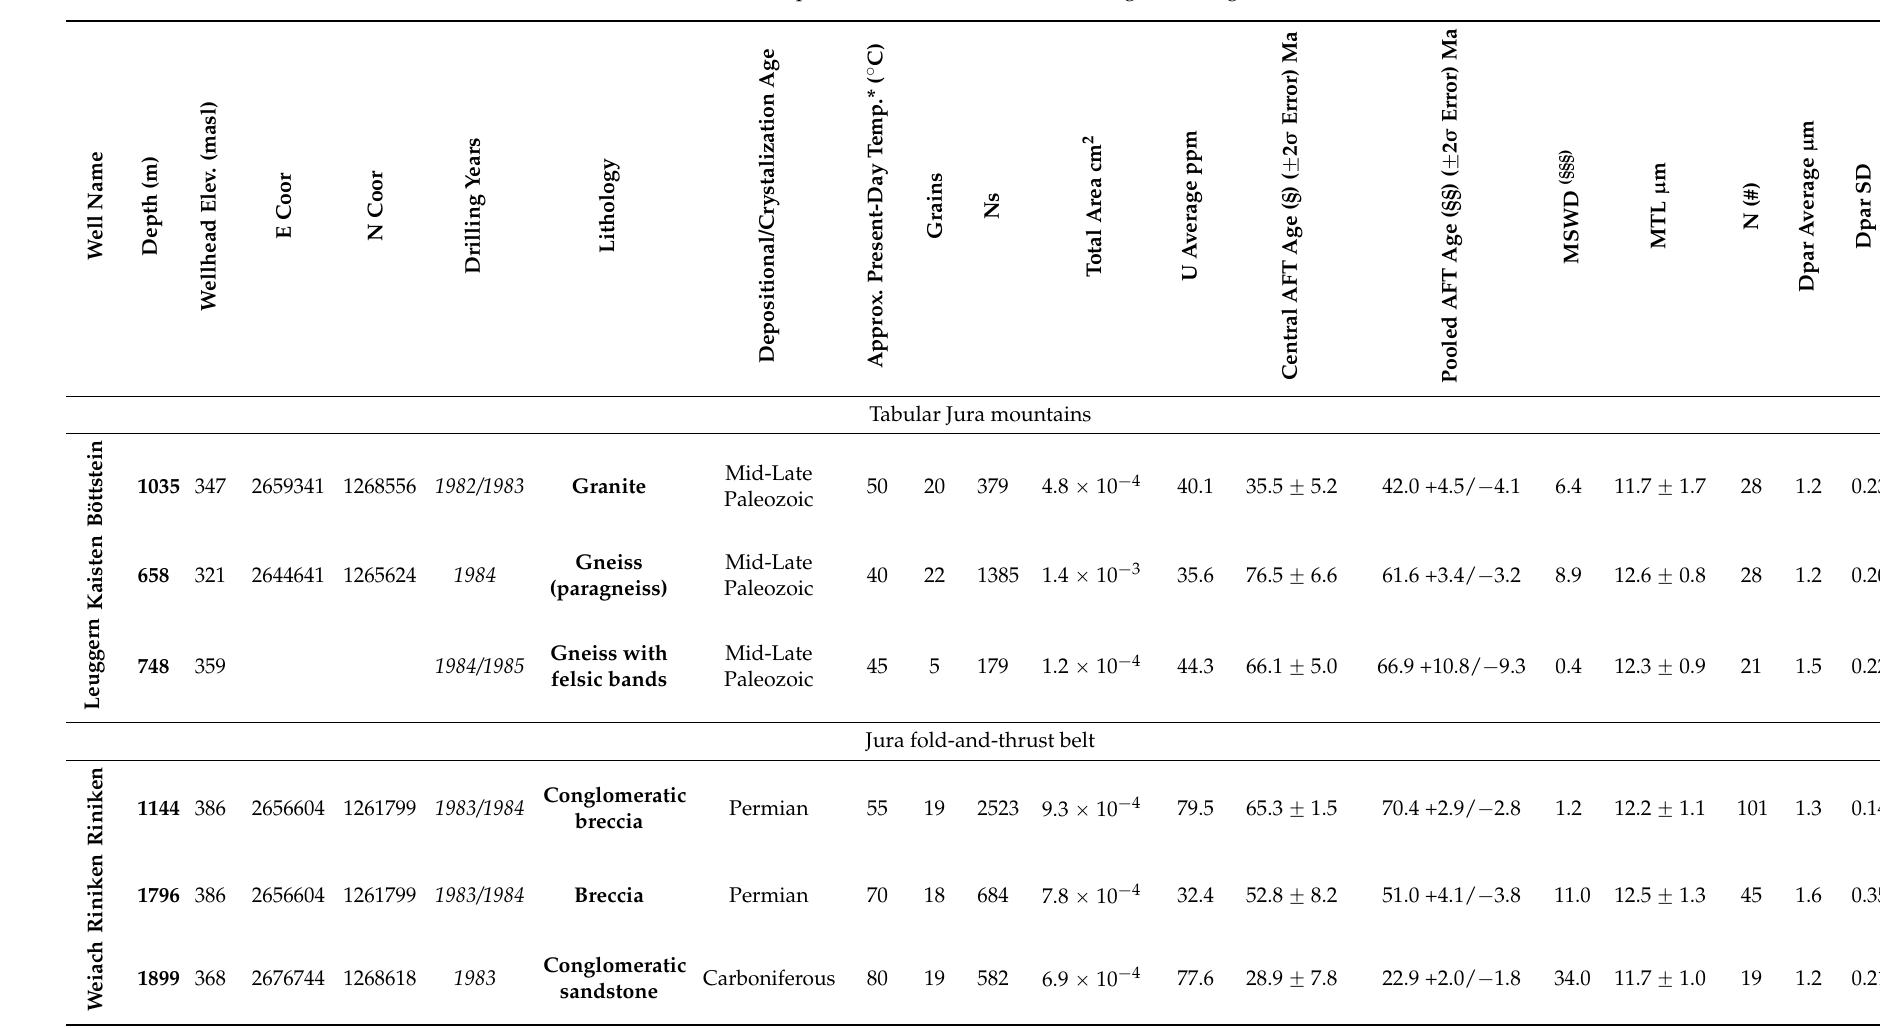
Table 1. New apatite fission track LA–ICP–MS age and length